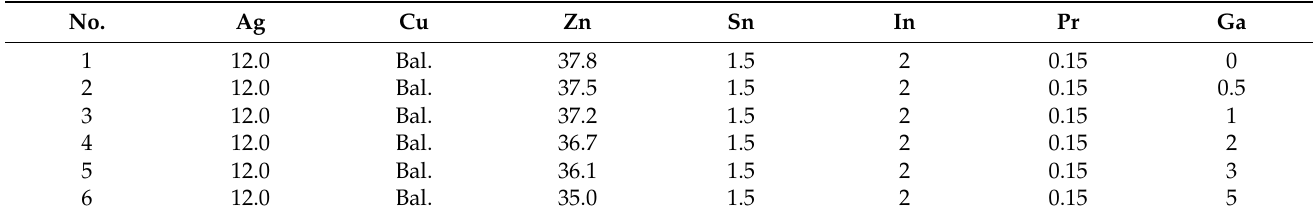
Table 1. Chemical composition of the novel low-silver filler metals (wt.%).